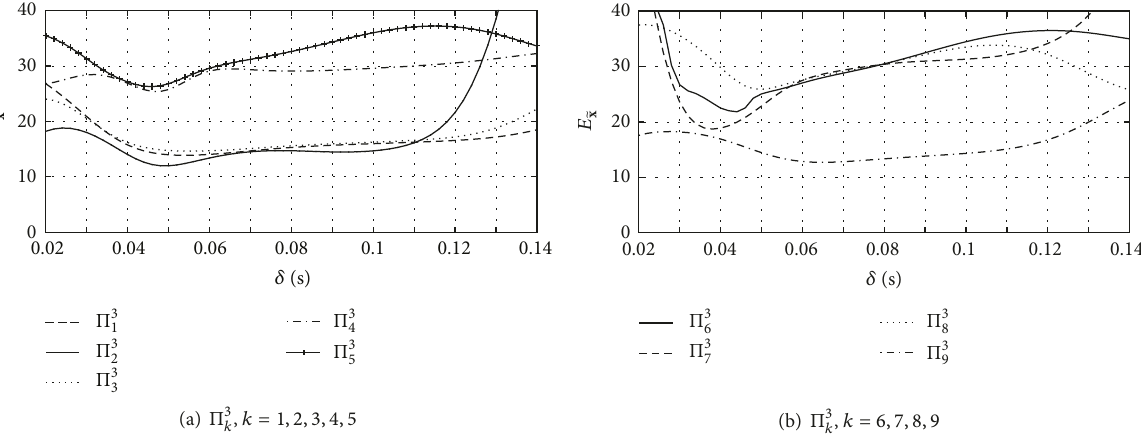
Figure 7: Function 𝐸 ̃ x (𝛿) computed with three instrumented